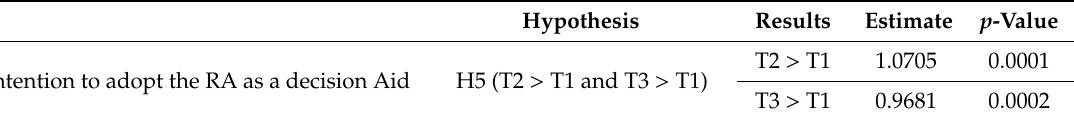
Table 3. Participants’ intention to adopt the recommendation agent